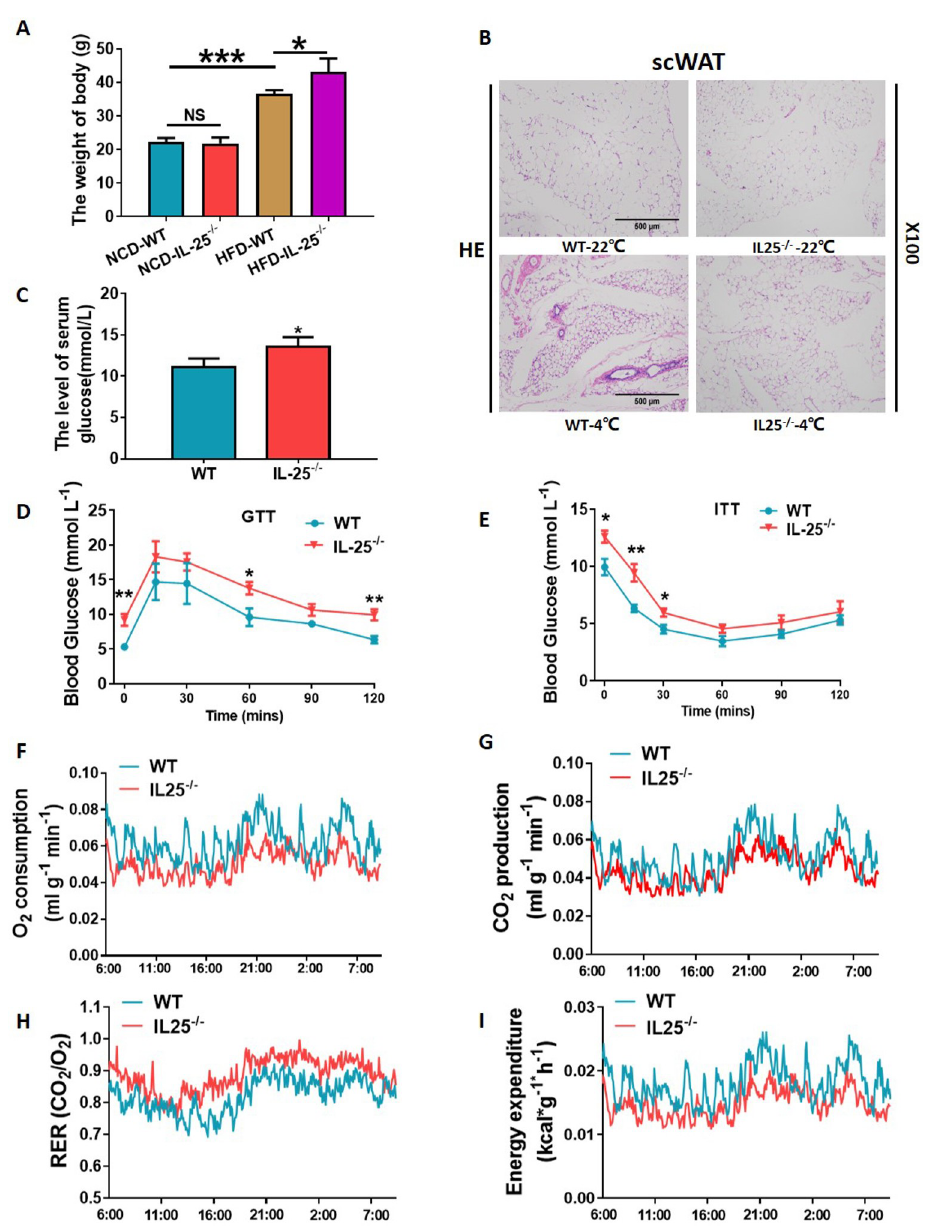
Fig 6. Depletion AU : PleasechangeproduciontoproductioninsubpartGinFig 6 andprovideanewFig 6 file : of IL-25 altered the metabolism of glucose, lipid, and energy expenditure. (A) The change of body weight in IL-25 − / − mice and control mice that were fed with an NCD or HFD. (B) WT and IL-25 − / − mice were